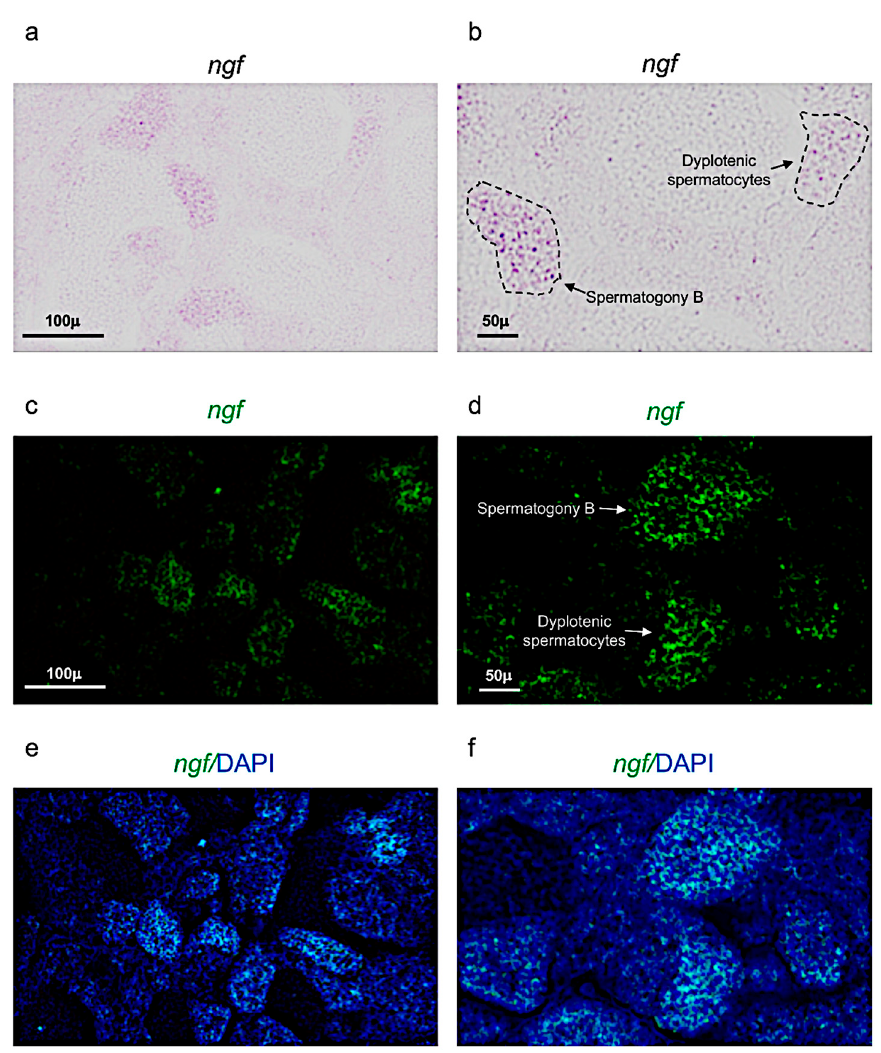
Figure 2. Ngf expression pattern in adult zebrafish testis. ( a , b ) Chromogenic in situ hybridization of ngf in adult zebrafish testis. ( c , d ) Fluorescence in situ hybridization of ngf in adult zebrafish testis. ( e , f ) Fluorescence in situ hybridization of ngf and cell nuclei (DAPI), in adult zebrafish testis. Scale bars are: 100 µ ( a , c , e ); 50 µ ( b , d , f ).